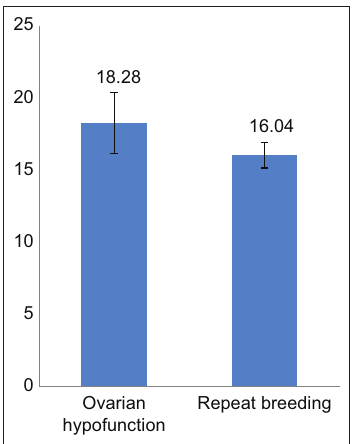
Figure-1: Average days open in beef cattle with ovarian hypofunction and repeat breeding in Jepara